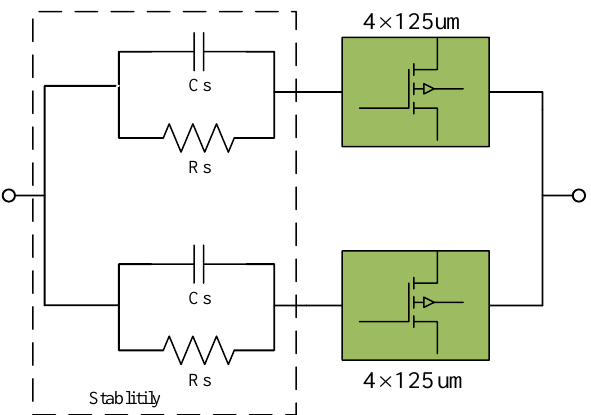
Figure 3. Block diagram of the stability circuits.